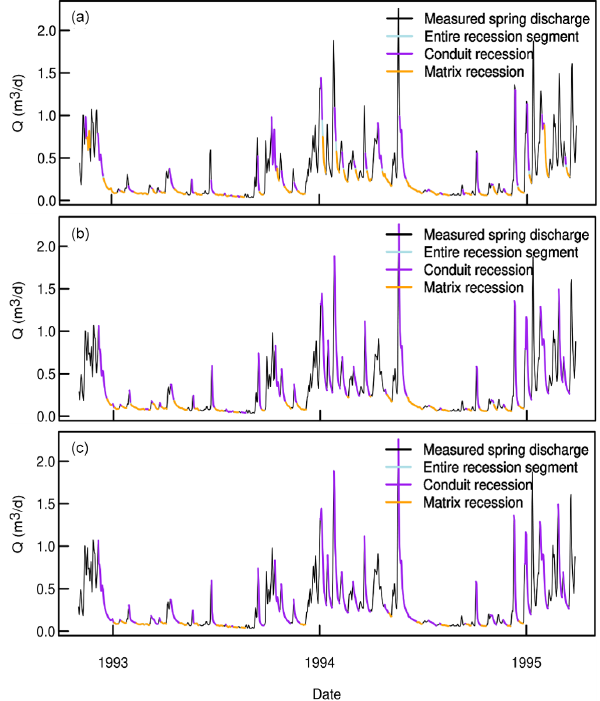
Figure A4. Saivu spring discharge hydrograph and extracted reces- sion events recognized by the three REMs: (a) Vogel, (b) Brutseart, and (c)